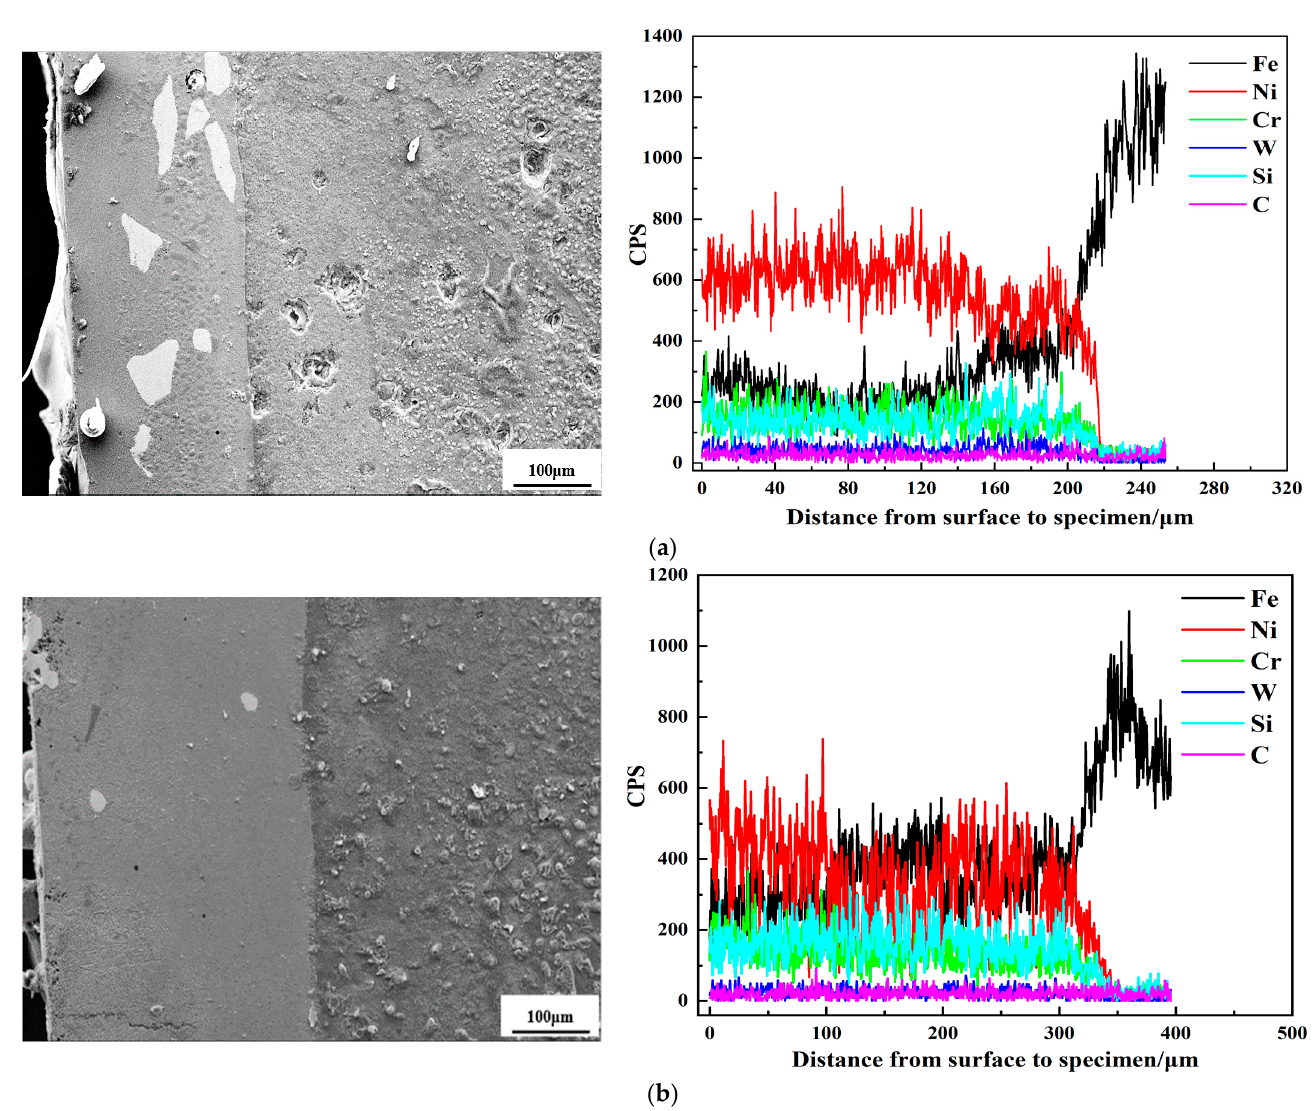
Figure 7. Microstructure of the coating and substrate (65 Mn steel substrate): ( a ) 1200 W SEM image and elemental analysis; ( b ) 1600 W SEM image and elemental analysis.